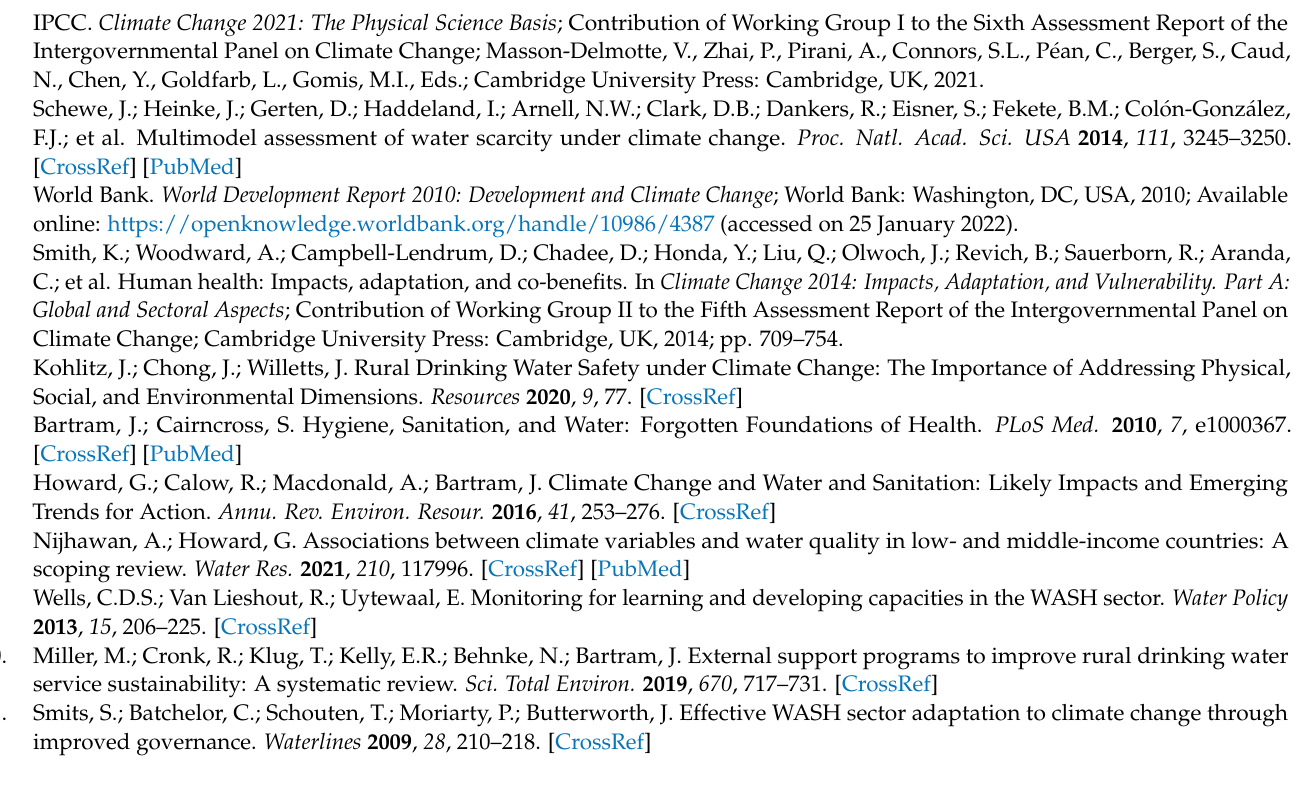
Ethiopia; Table S2: Interview guide for KIIs completed in Nepal; Table S3: Number of participants in KIIs and FGDs; Table S4: Rationale for assigning environmental indicator scores; Table S5: Rationale for assigning infrastructure indicator scores; Table S6: Rationale for assigning management indicator scores; Table S7: Rationale for assigning institutional support indicator scores; Table S8: Rationale for assigning community governance and engagement indicator scores; Table S9: Rationale for assigning supply chain indicator scores; Table S10: Slope classification used to score water supplies on the environment